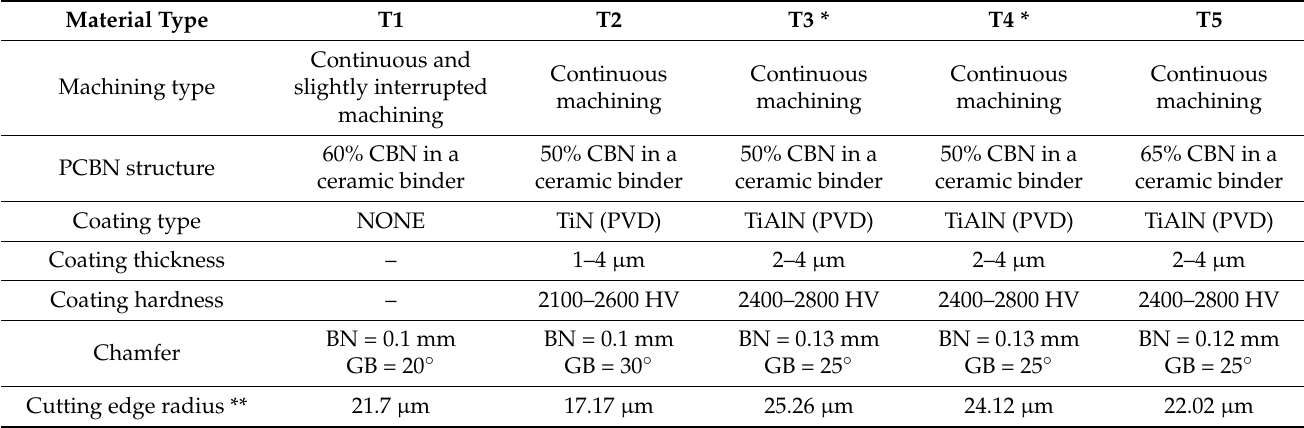
Table 2. Material of the cutting tools adopted for the test.